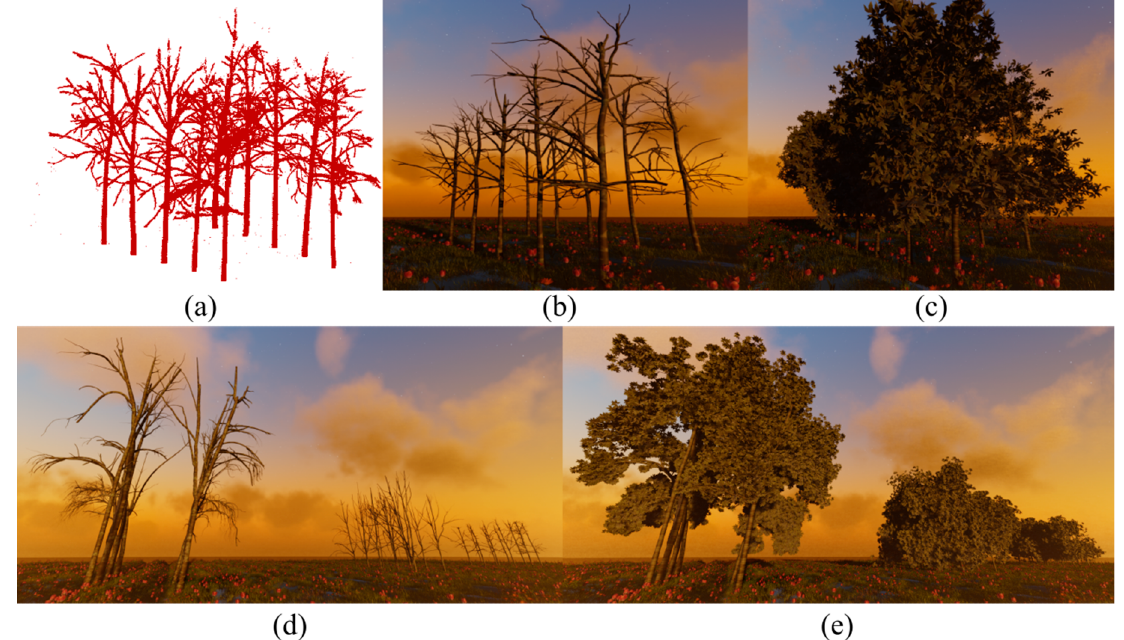
Figure 11. The modeling results with twilight as the background. ( a ) Point clouds of 5-year-old rubber trees; ( b ) branching models of 5-year-old rubber trees; ( c ) models of 5-year-old-rubber trees with branches and leaves; ( d ) overview of branching models of rubber trees; ( e ) overview of branching models of rubber trees with branches and leaves. Table 2. The growth variables retrieved from the modeling process and scanned